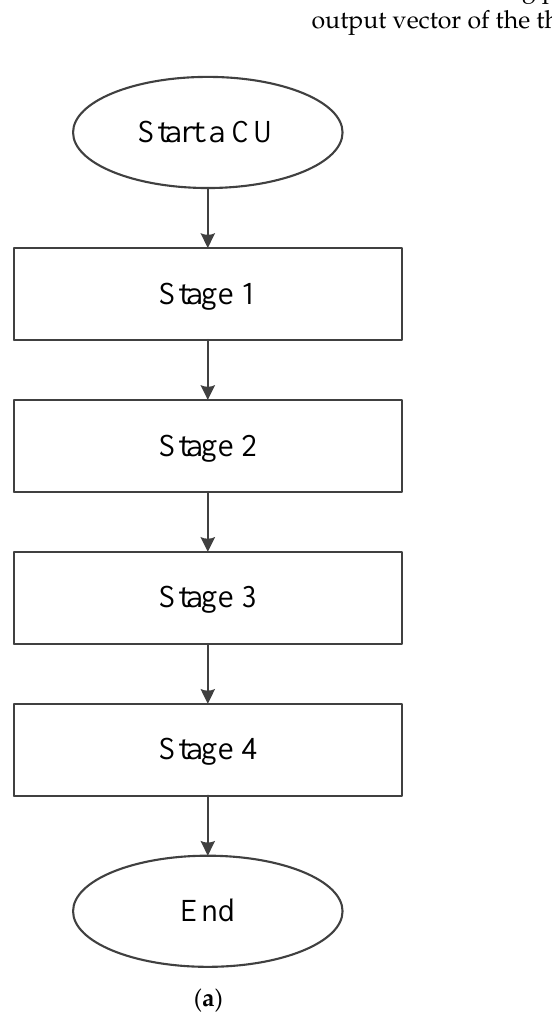
Figure 5. Flowchart of CU partition decision based on MET-CNN. ( a ) Overall flow chart; ( b ) detailed flowchart of the i -th